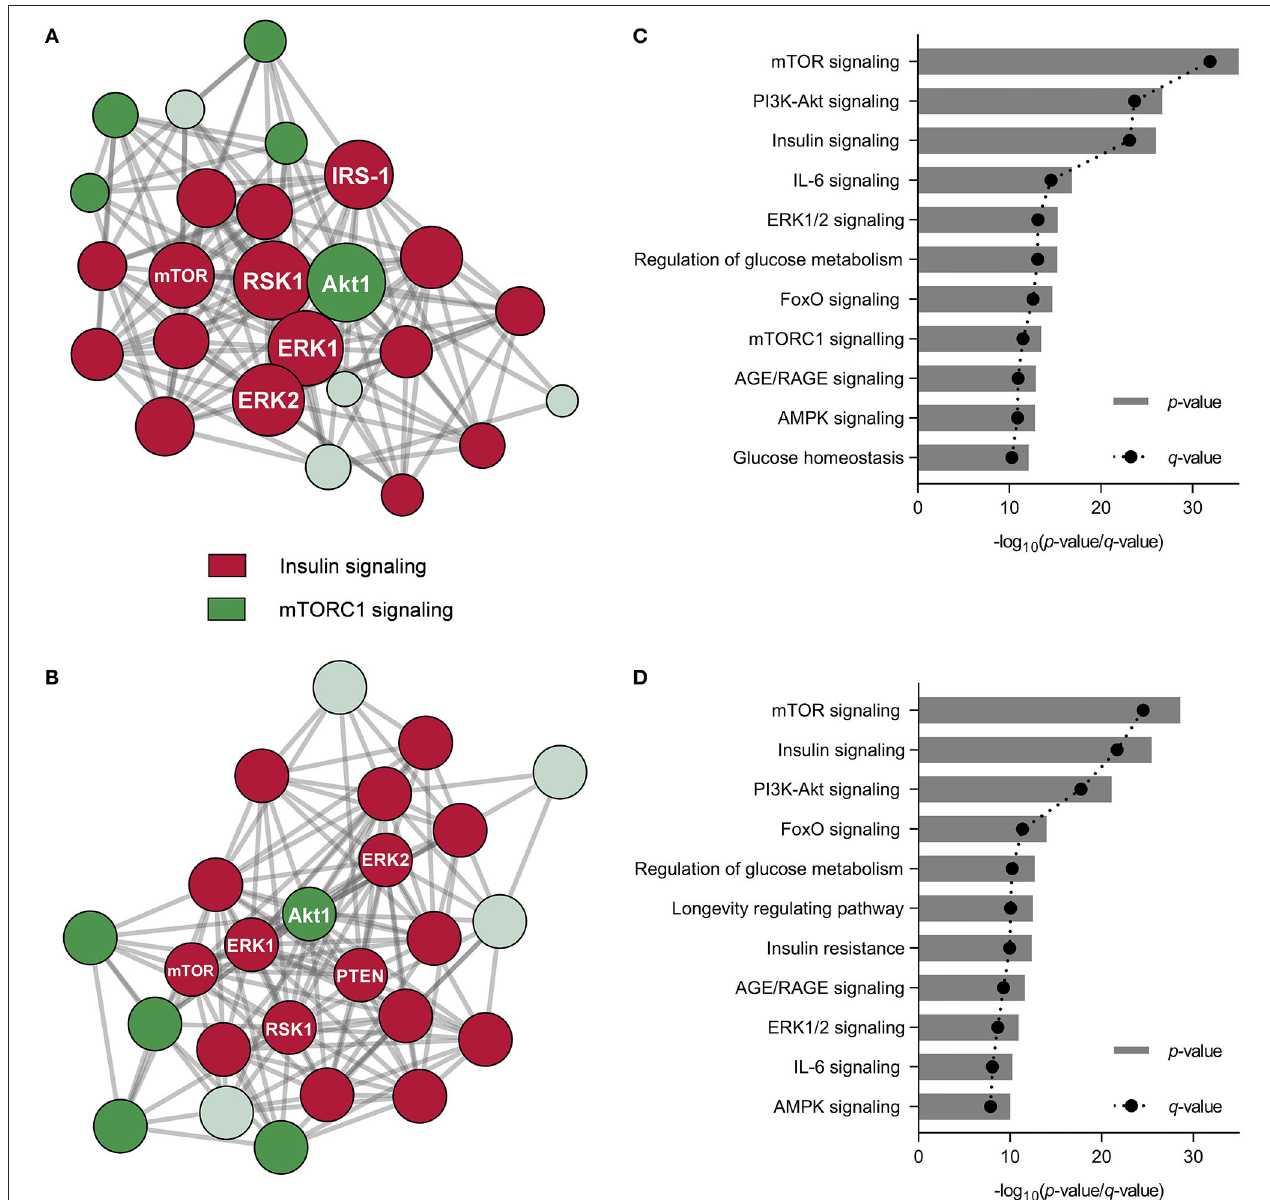
FIGURE 3 | Coffee silverskin (CSE) and coffee husk (CHE) aqueous extracts’ bioactive compounds differentially regulated the phosphorylation of proteins associated with cell signaling pathways. Protein-protein interaction networks diagrams from the distinctly phosphorylated protein in HepG2 cells after the co-treatment with palmitic acid (PA, 500 µ mol L − 1 ) and the aqueous extracts (100 µ g mL − 1 ) (considering cells just treated with PA as the control group) (A,B) and metabolic pathways related to the distinctly phosphorylated proteins (C,D)